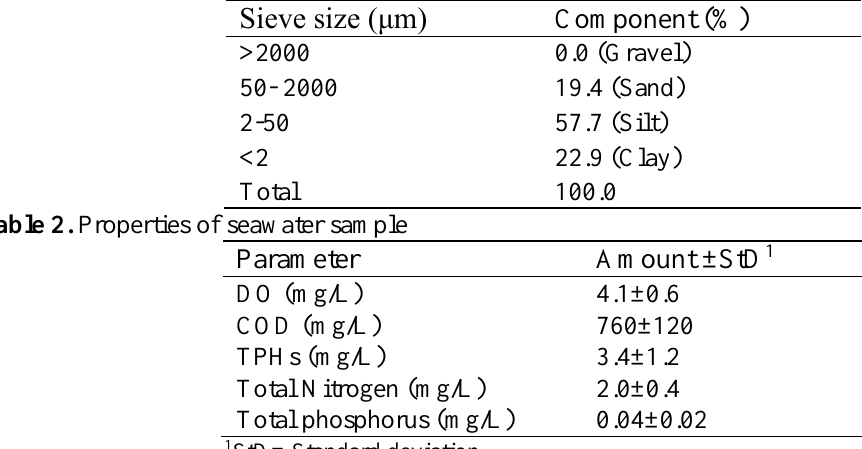
Table 1. Physical properties of sediment sample